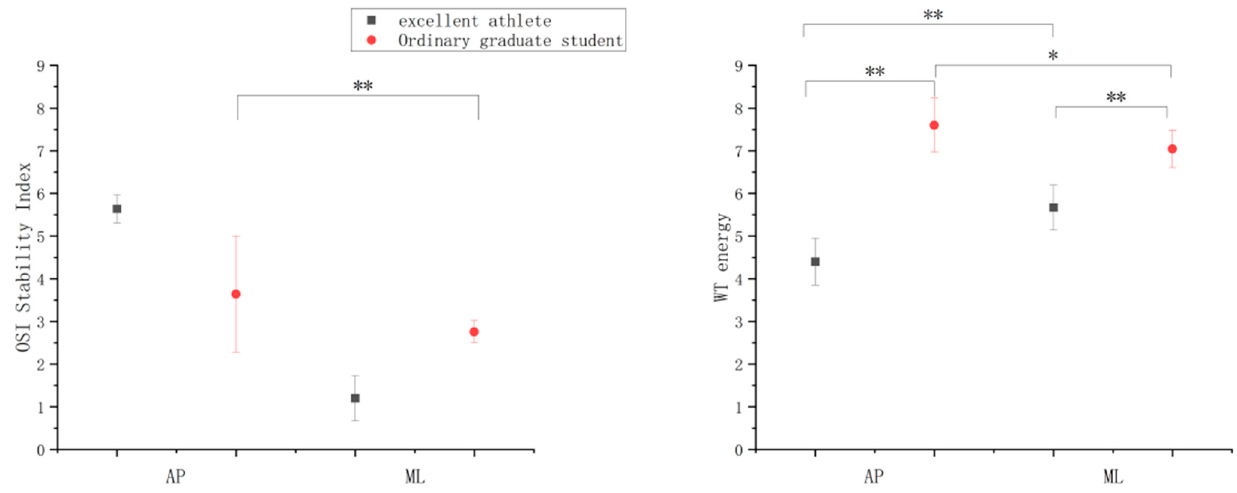
Figure 2. Comparison of significance between the WT and OSI of different subjects. Note: * indicates the difference between different subjects in different standing directions p < 0.05; ** indicates the difference between different subjects in different standing directions p < 0.01.